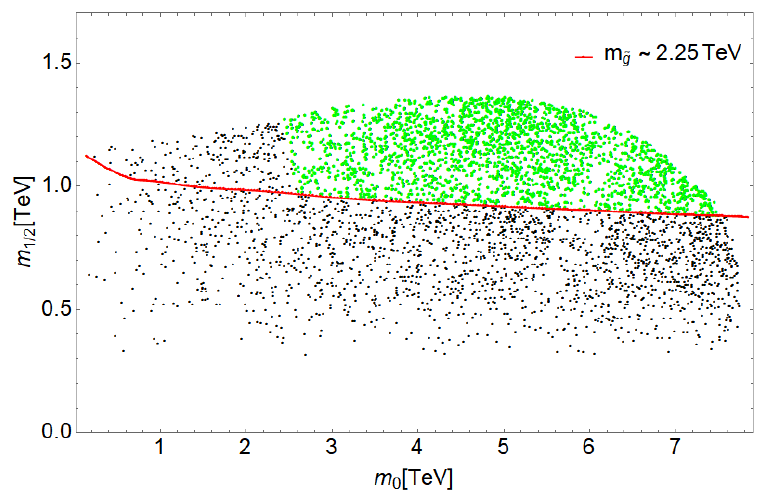
Figure 3. Locus of n = 1 lansdscape scan points for the NUHM2 model with (cid:22) = 200 GeV in the m vs. m 0 plane along with recent LHC Run2 constraints for A 0 = (cid:0) 1 : 6 m 0 , m A = 2 TeV and 1 = 2 tan (cid:12) = 10. The soft terms m 0 and m are selected with n = 1 and (cid:1) EW < 30 so that the weak 1 = 2 scale is within (cid:24) 4 of its measured value. The red contour corresponds to the LHC Run 2 limit that m ~ g & 2 : 25 TeV. Green points are allowed by LHC Run 2 constraints (see text) while black points are excluded by LHC Run